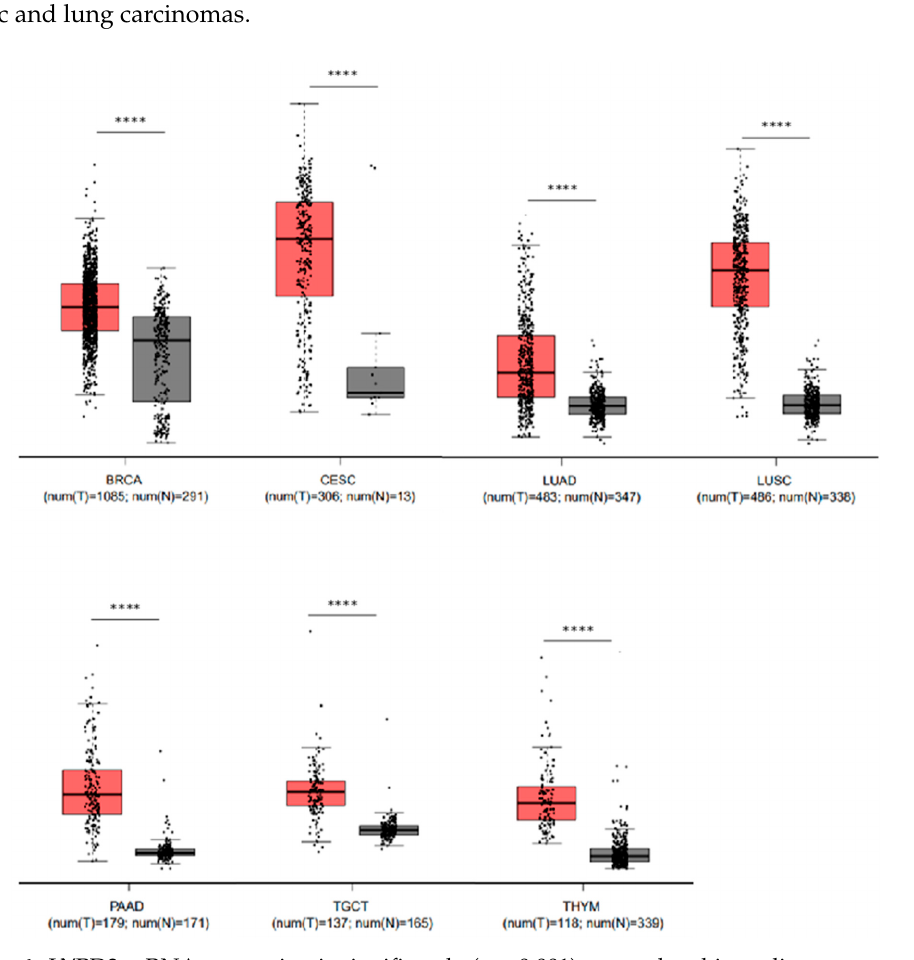
Figure 4. LYPD3 mRNA expression is significantly ( p < 0.001) upregulated in malignant cancer (T) versus the normal tissue (N) counterpart. Box and whisker plots illustrating the mRNA expression levels of LYPD3 in the following cancer versus normal tissue: BRCA—breast cancer, CESC—cervical squamous cell carcinoma and endocervical adenocarcinoma, LUAD—lung adenocarcinoma, LUSC—lung squamous cell carcinoma, PAAD—pancreatic adenocarcinoma, TGCT—testicular germ cell tumours and THYM—thymoma. Cancer are coloured red whilst normal are coloured grey. Each point represents an individual data point and the number of data points in each analysis is stated under the x -axis. The log2 fold change cut-off is 1 and differential analysis is by one-way ANOVA, using disease state as the variable for calculating differential expression.